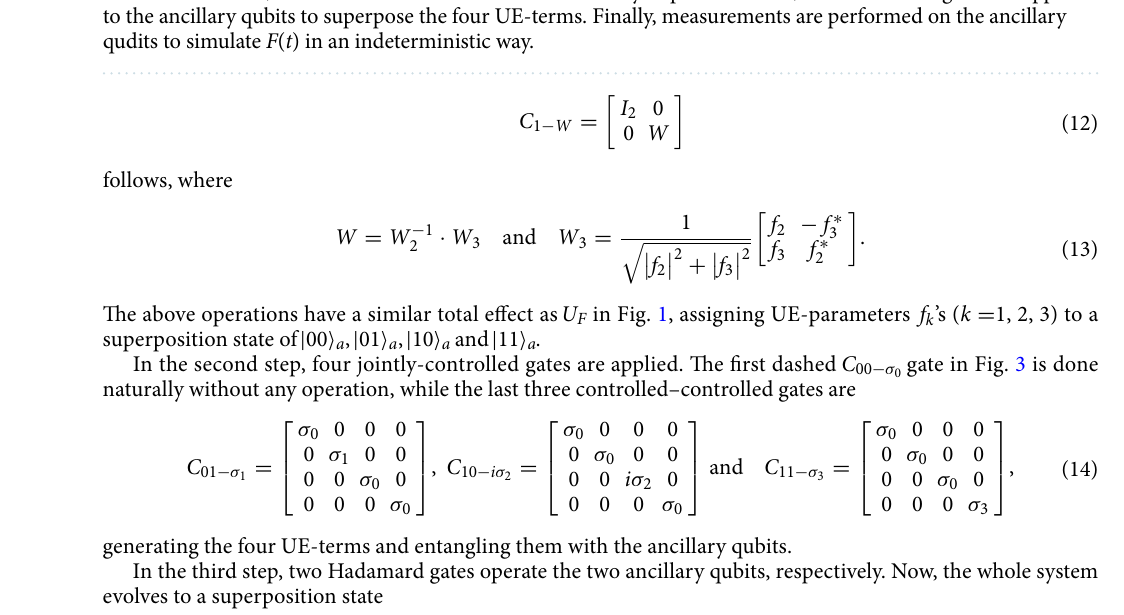
ψ e by R ψ further. The first step is to assign the | �